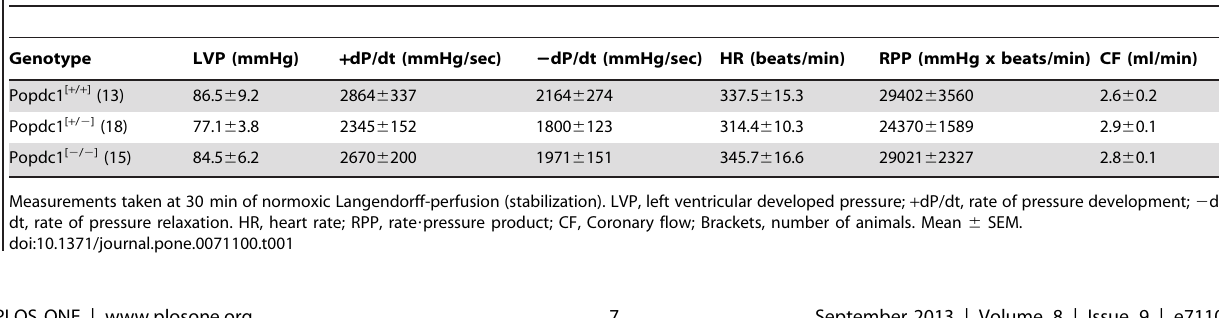
Table 1. Basal heart